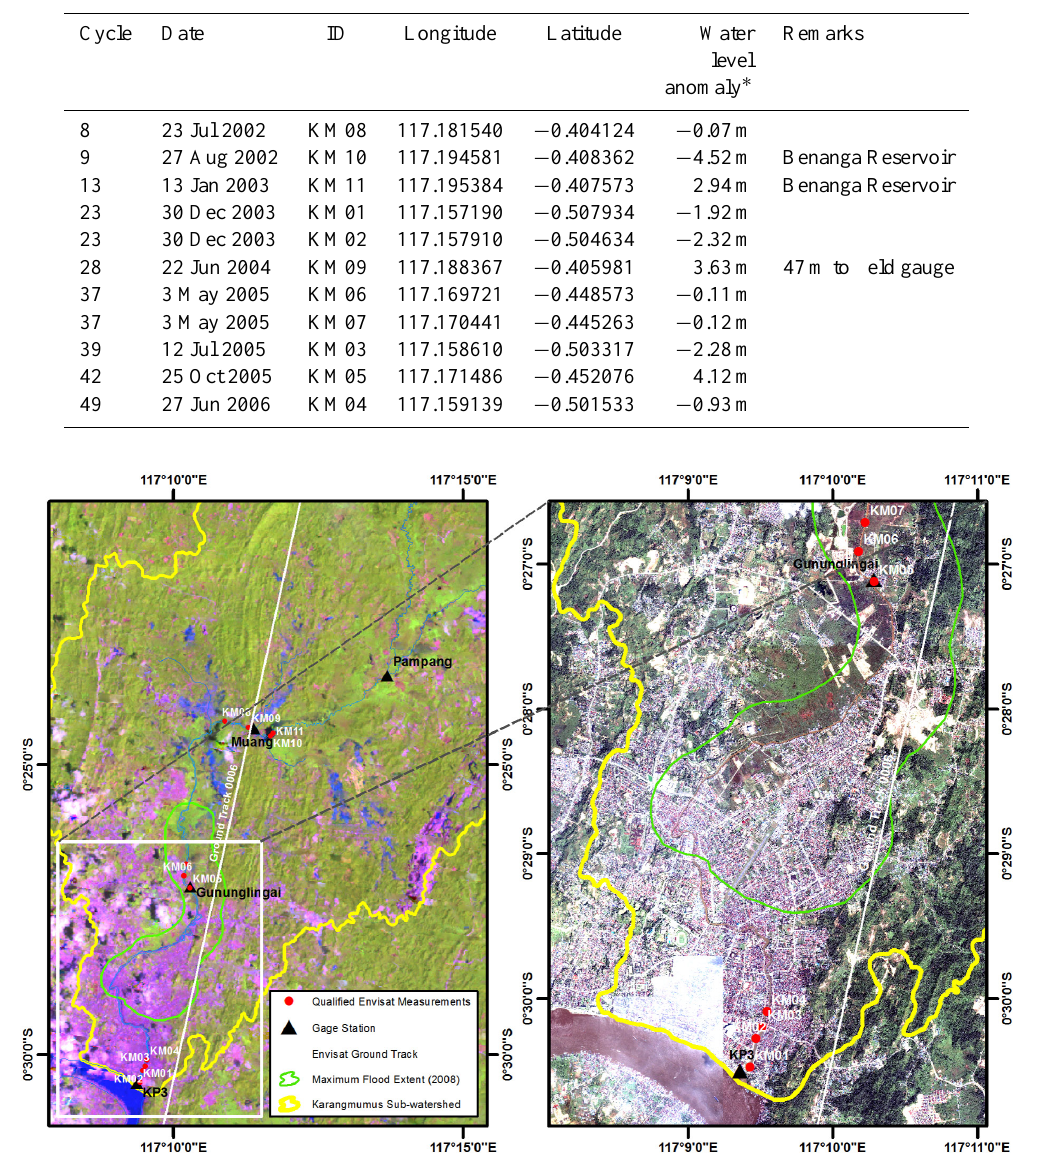
Table 4. Qualified Envisat RA-2 altimetry measurements for the Karangmumus River.